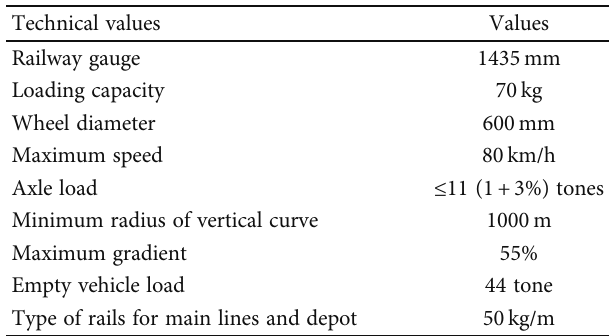
Figure 2: Wheels wear prediction methodology. Table 1: Technical parameters of passenger car for Addis Ababa light railway